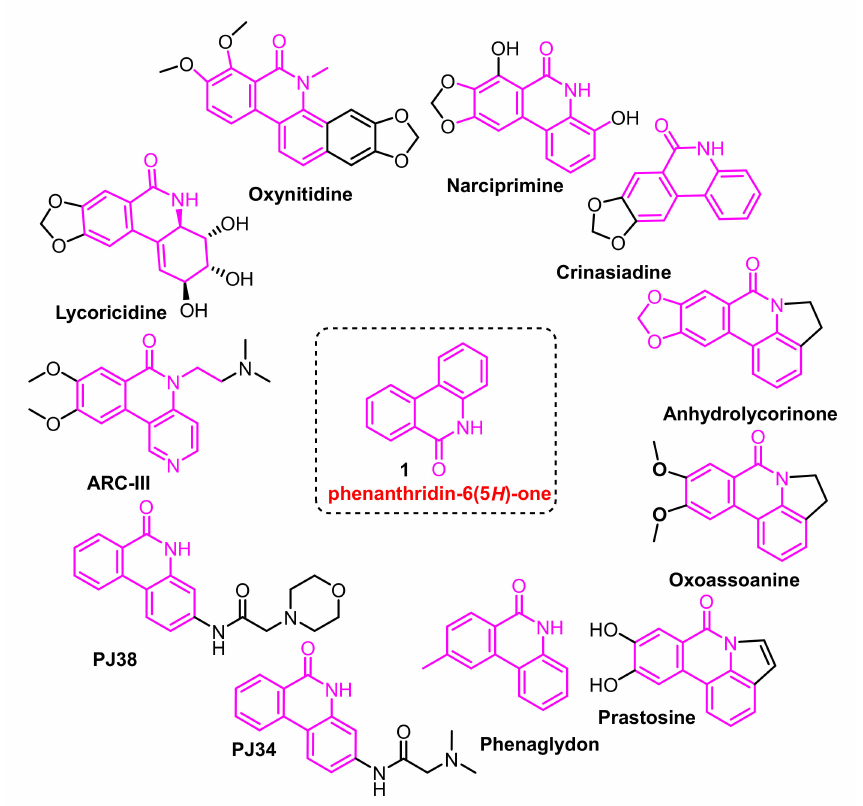
Scheme 1. Selected examples of biologically important